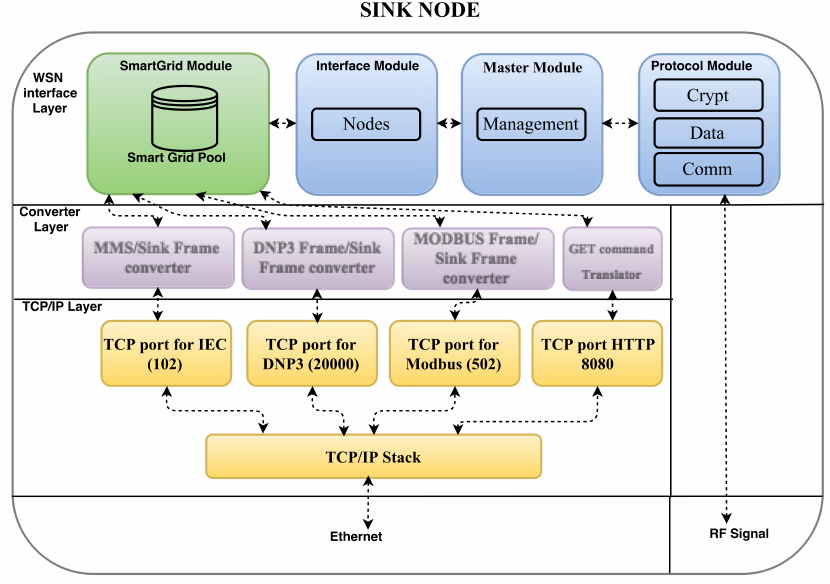
Figure 2. Middleware components within the sink